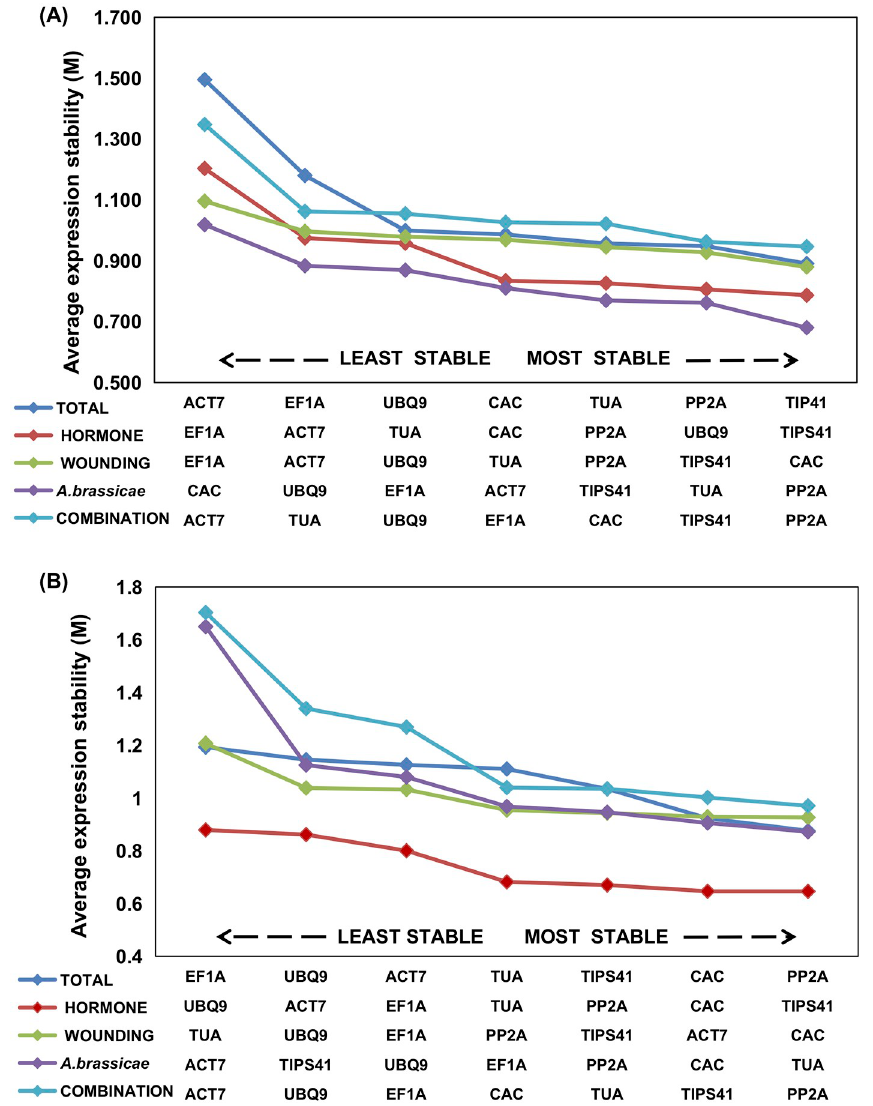
Fig 3. Average expression stability and ranking of seven reference gene predicted by geNorm. (A) B . juncea (B) C . sativa . Average expression stability value (M) is calculated by stepwise exclusion of the least stable reference gene across each experimental set. Lowest M value represents most stable reference gene, while highest value indicates unstable